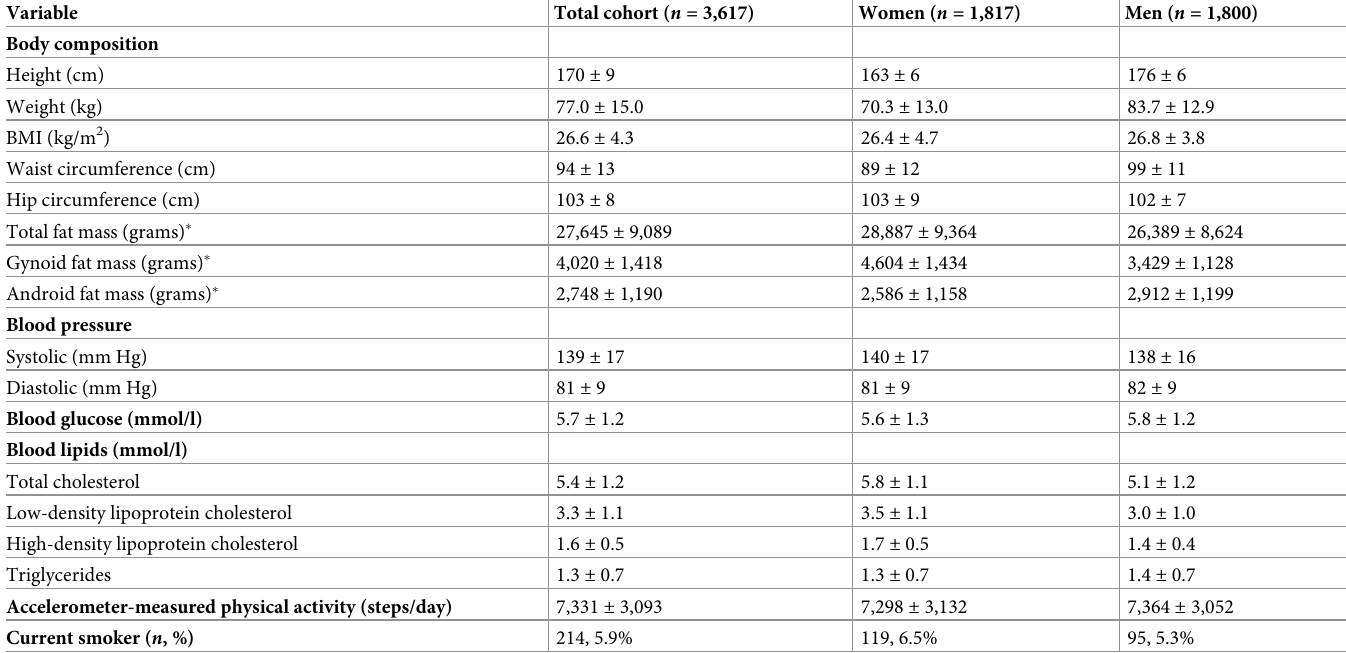
Table 2. Additional baseline characteristics collected from participants in the Healthy Ageing Initiative study. Variable